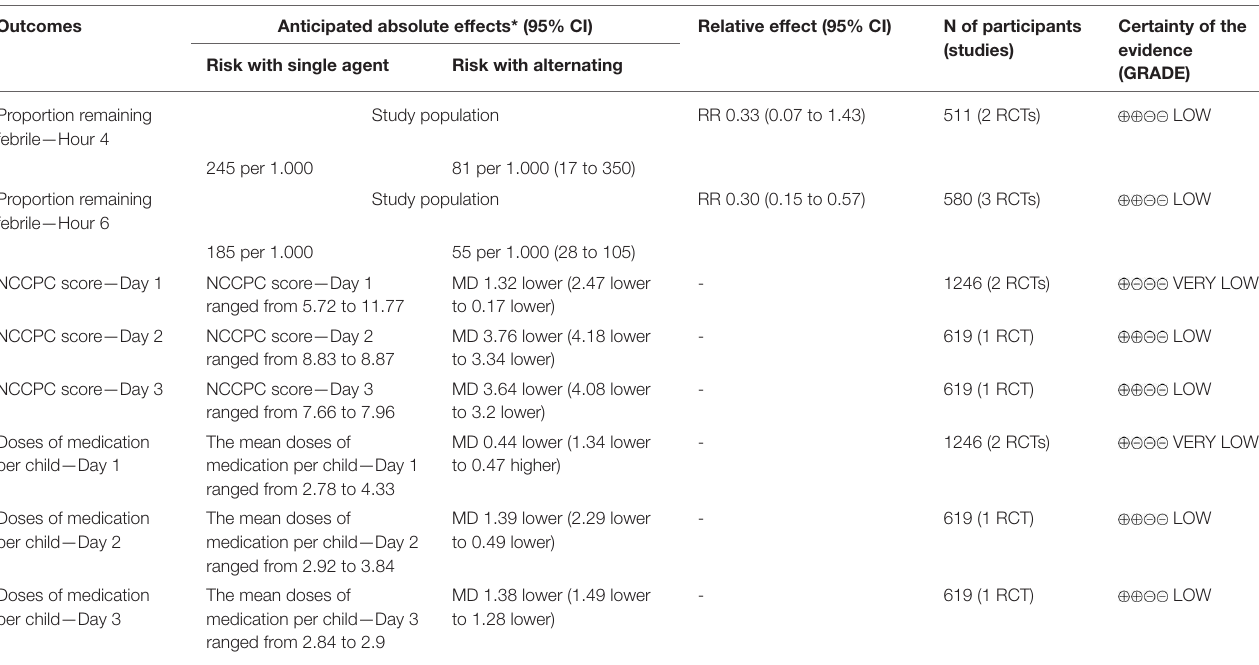
TABLE 7 | Summary of findings: alternating therapy vs. single